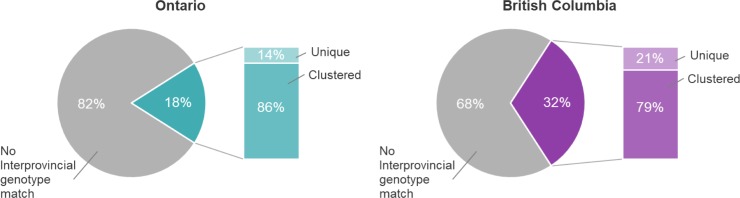
Intra- and interprovincial 24-locus MIRU-VNTR genotypic clustering, Ontario and British Columbia (2008–2014).Each pie represents the proportion of isolates within the province that have a genotype match in the other. For the group that does have an interprovincial match, the stacked bar graphs show the relative frequency of isolates that are clustered or unique within the province.